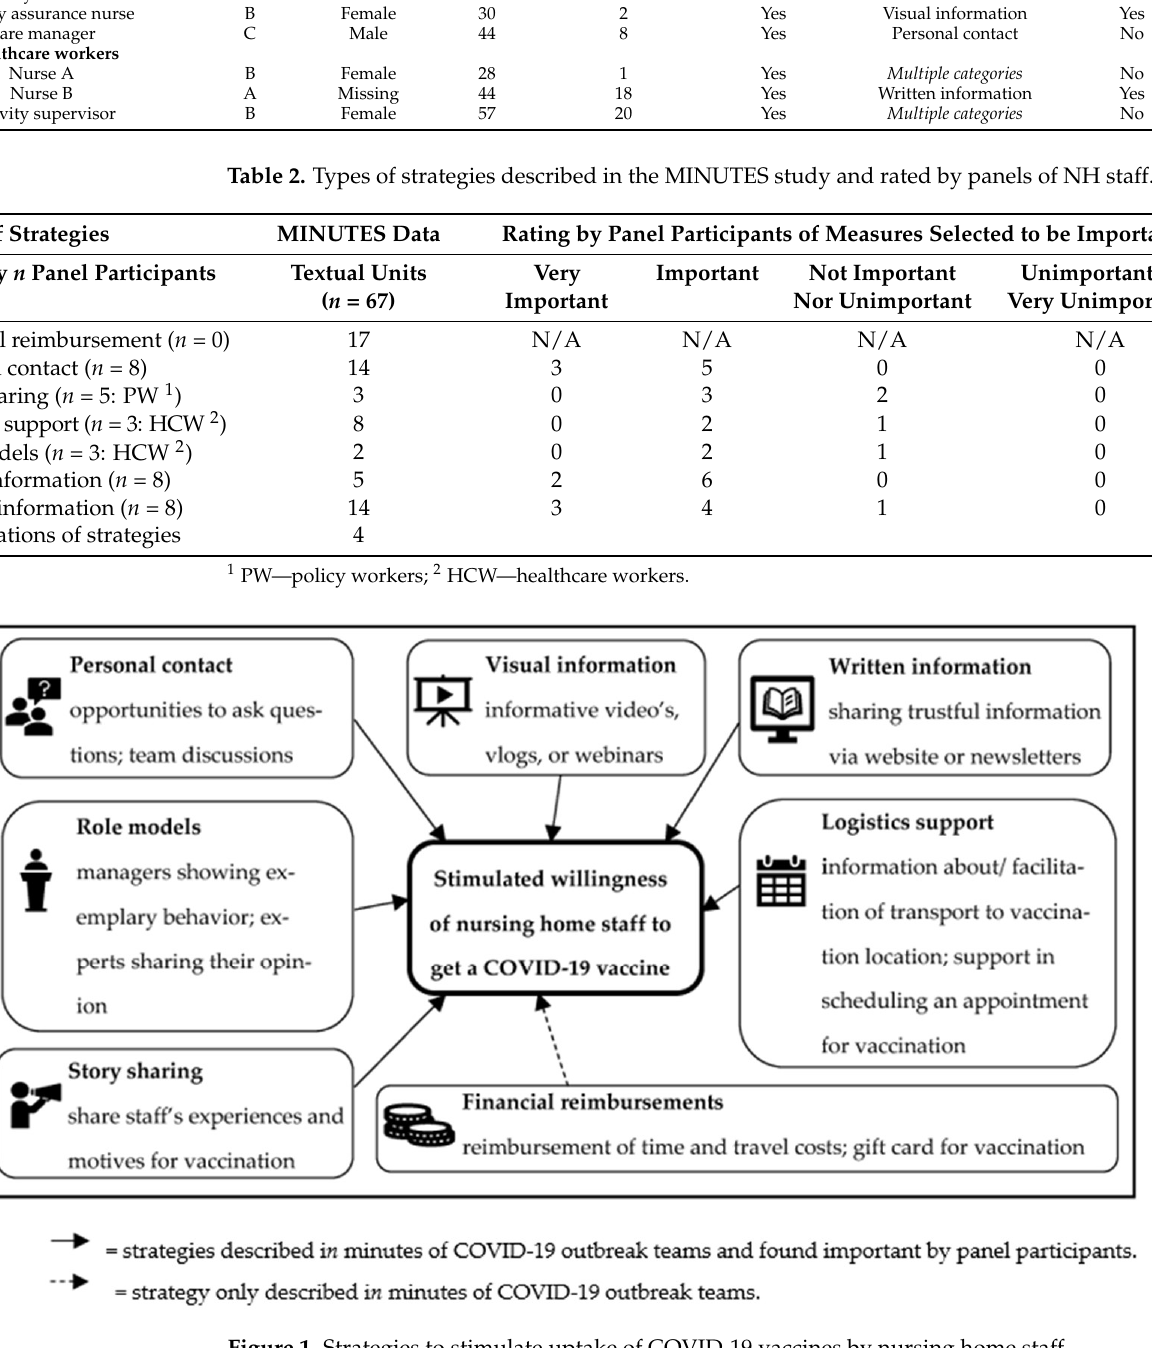
Figure 1. Strategies to stimulate uptake of COVID-19 vaccines by nursing home staff.